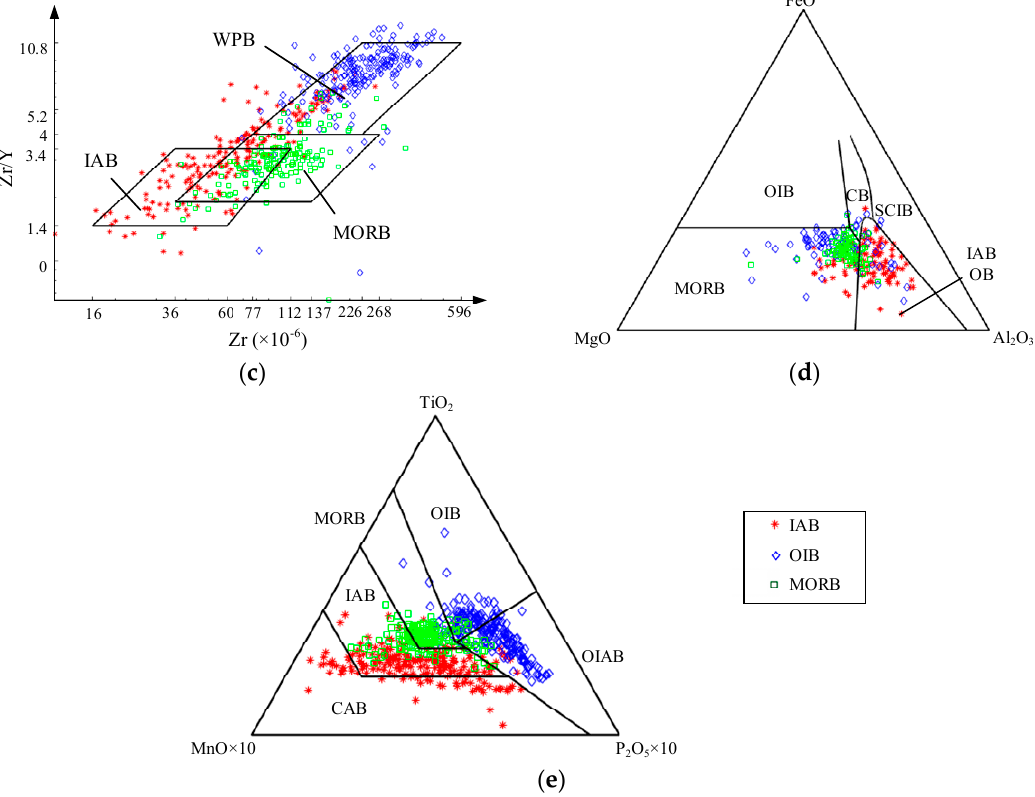
Figure 1. Classical basalt tectonic discrimination diagrams: ( a ) diagram of Ti-Zr-Y, ( b ) diagram of Ti-Zr, ( c ) diagram of Zr/Y-Zr, ( d ) diagram of FeO T -MgO-Al 2 O 3 and ( e ) diagram of TiO 2 -MnO-P 2 O 5 .